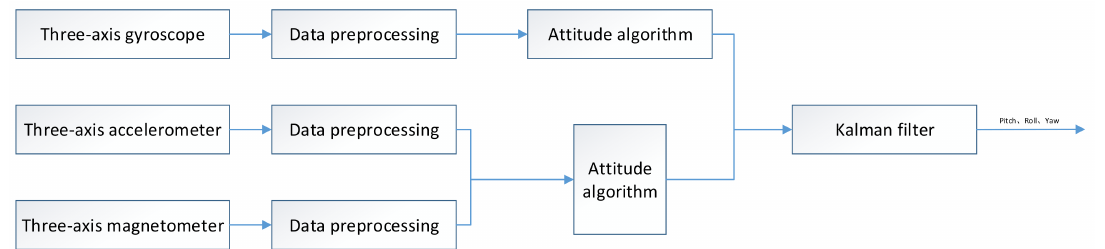
Figure 1. Schematic diagram of UAV attitude calculation algorithm. Processing two groups of data with Kalman filter in order to get the accurate and stable attitude data of the